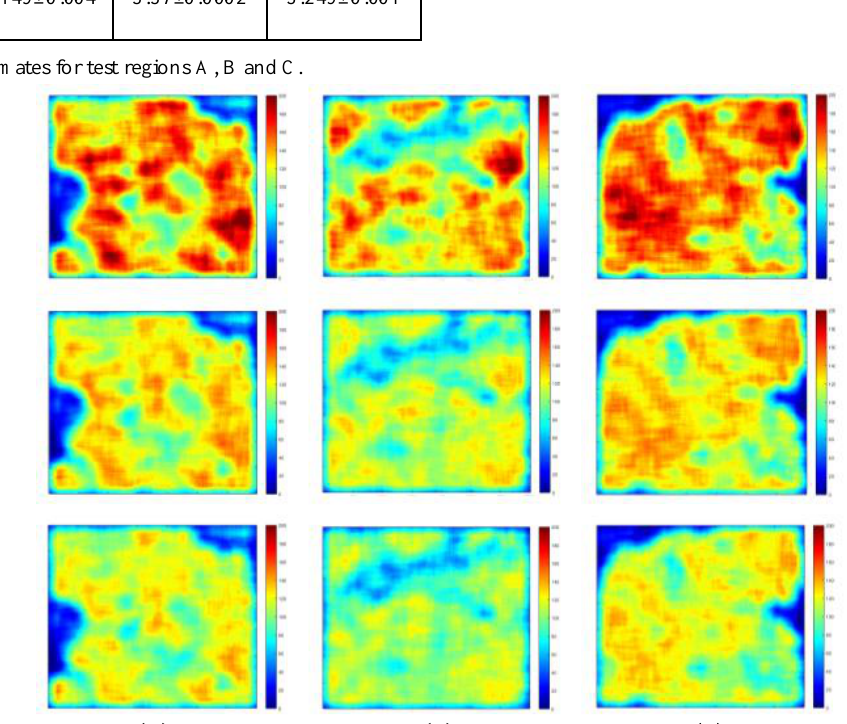
Figure 7. Effect of removal of secondary candidates on the crater densities of test regions A, B and C. First row: Detected craters with template matching. Second row: Crater density after applying the SCD algorithm. Third row: Crater density after applying the binned SCD